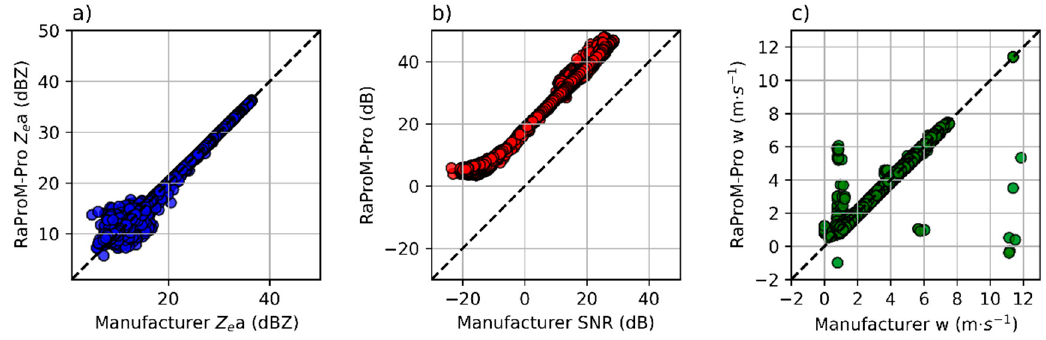
Figure 3. Scatter plots comparing the manufacturer and the RaProM- Pro processing. ( a ) Equivalent radar reflectivity, ( b ) signal-to-noise ratio and ( c ) Doppler vertical velocity. Data were recorded on 21 April 2020 from 10 h to 14 h UTC.